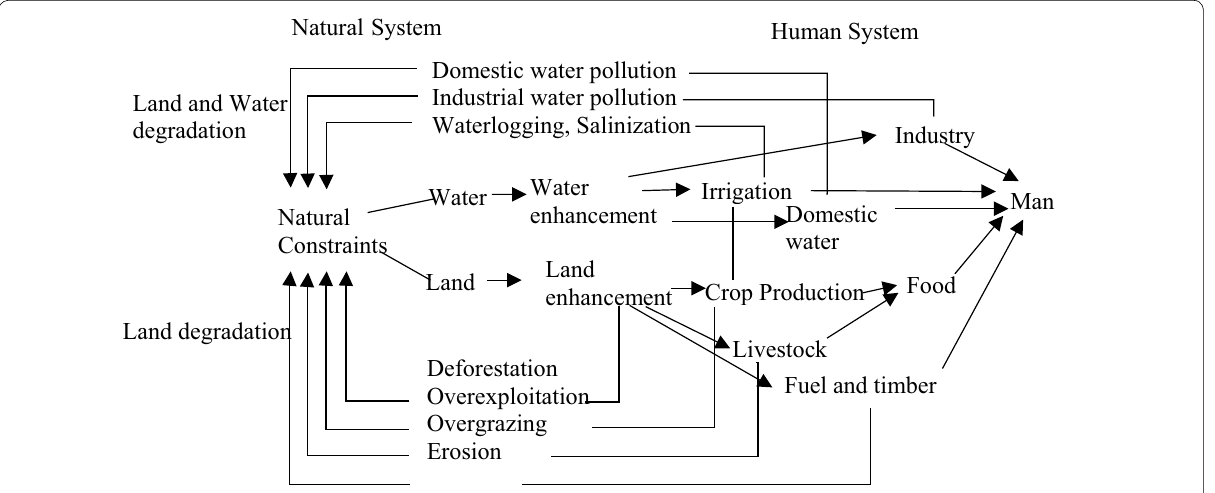
Fig. 1 Complex nature of interactions and feedbacks between the natural and human system (After Falkenmark 1986a,